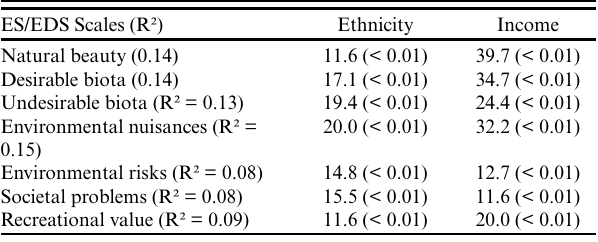
Table 5 . Analysis of covariance (ANCOVA) results for effect of ethnicity controlling for income: F Statistic (P Values). Ecosystem services (ES); ecosystem disservices (EDS). ES/EDS Scales (R²)